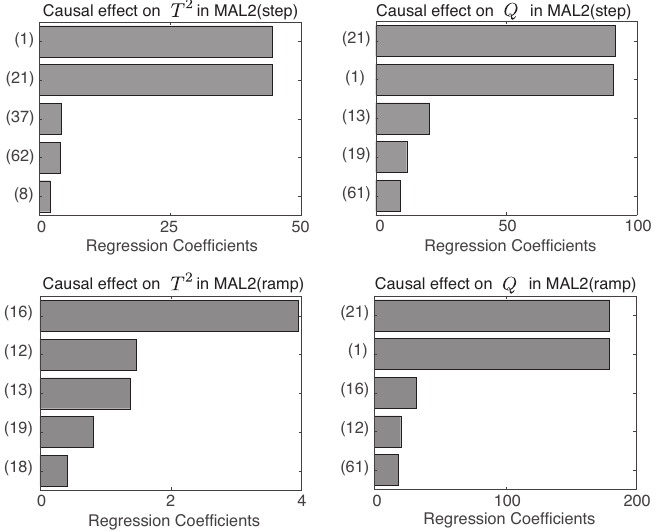
Figure 8. Fault diagnosis results of MAL2 with ramp change by causal